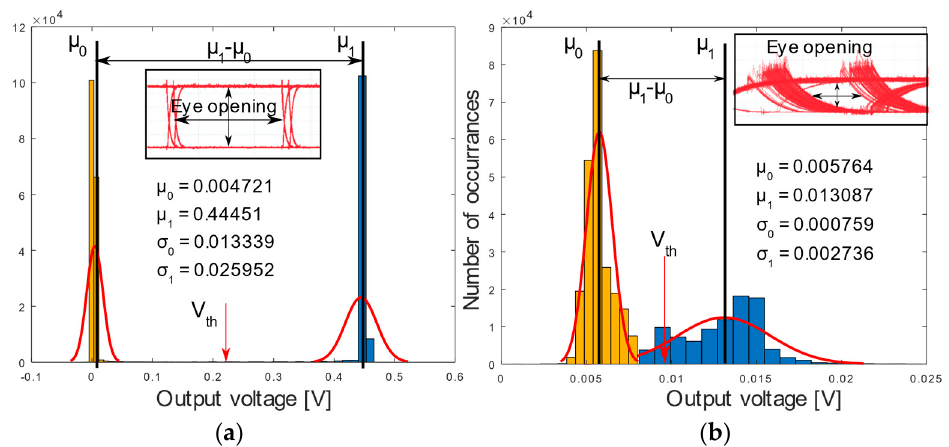
Figure 5. Eye diagram (inset) and signal constellation in ( a ) back-to-back configuration and ( b ) at 10 cm distance.